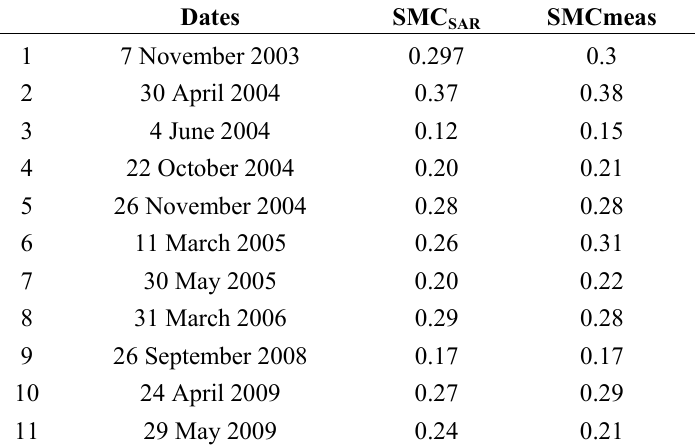
Table 2. Comparison between the average SMC values estimated from the backscatter of the images of Figure 2 (SMC , in m 3 /m 3 ) and the corresponding SMC values measured SAR on ground (SMCmeas, in m 3 /m 3 ), averaged on 23 fields.